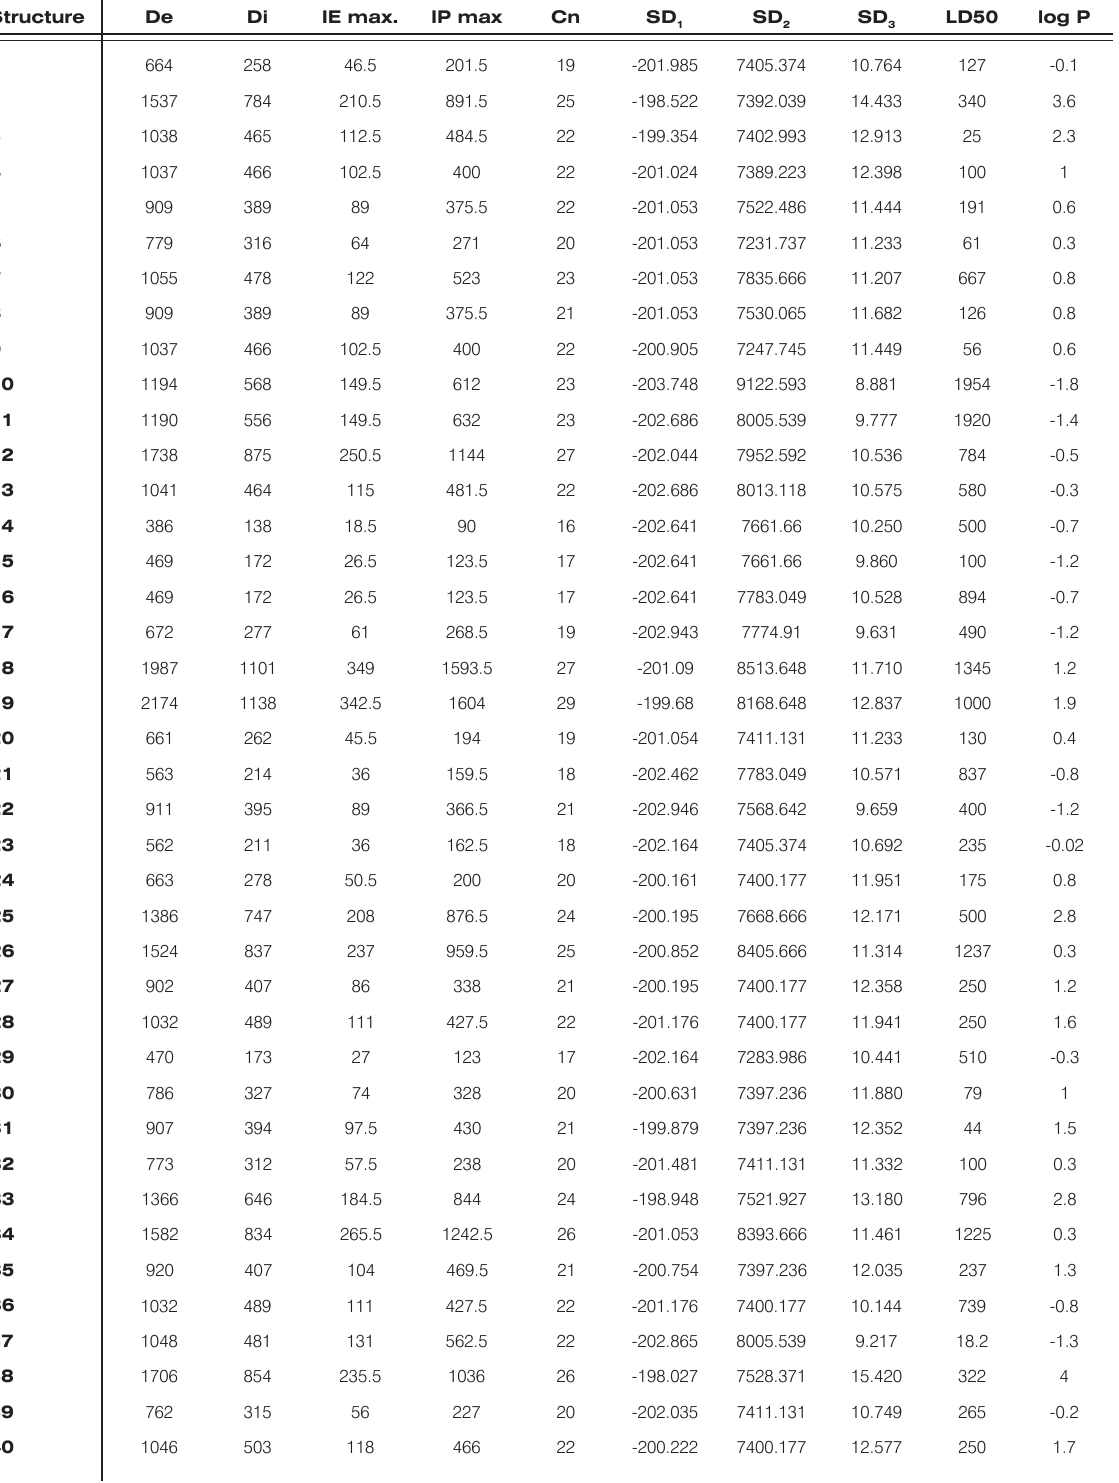
Table 3. Topological indices, correlating descriptors, log P and LD50 for the set of caffeines in Table 1.